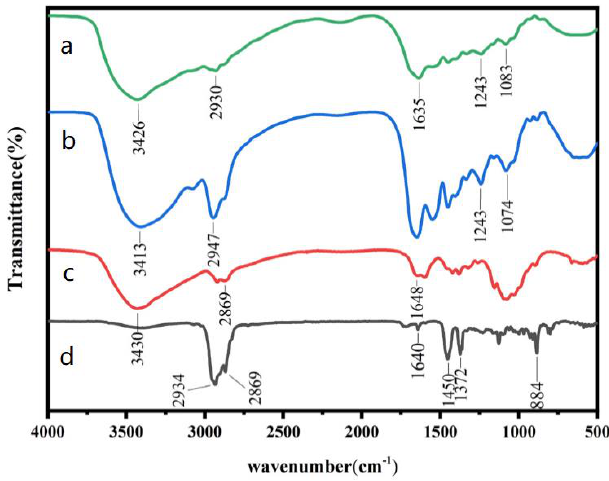
Figure 6. FTIR spectra: a = gelatin; b = CFEO microcapsules; c = chitosan; d = CFEO.